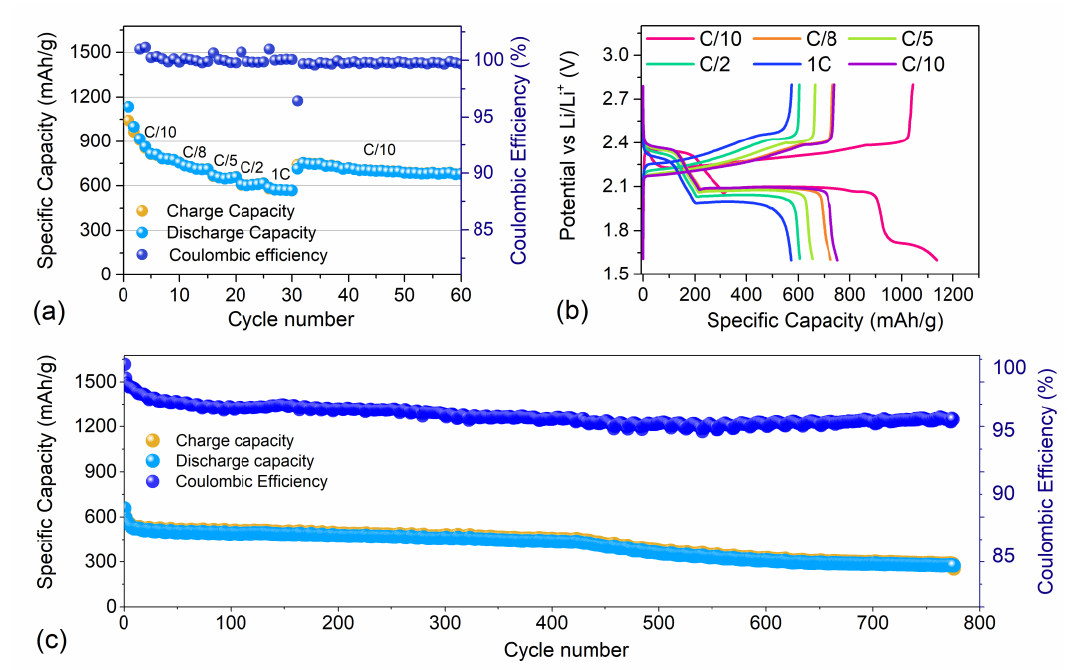
Figure 5. ( a ) Rate capability test and ( b ) relative voltage profiles of S80CNH20 performed at different current-rate: C/10 to 1C (=1675 mA/g) through C/8, C/5, C/2, and 1C and finally back to C/10. Sulfur loading of ~2 mg/cm 2 . ( c ) Galvanostatic cycling profile of the electrode performed in 2032-coin cells with DOLDME-LITFSI-LiNO 3 electrolyte carried out at C/4= 419 mA/g within 1.9 V and 2.6 V. Sulfur loading of ~2 mg/cm 2 (see Figure S4 in Supplementary Material for voltage